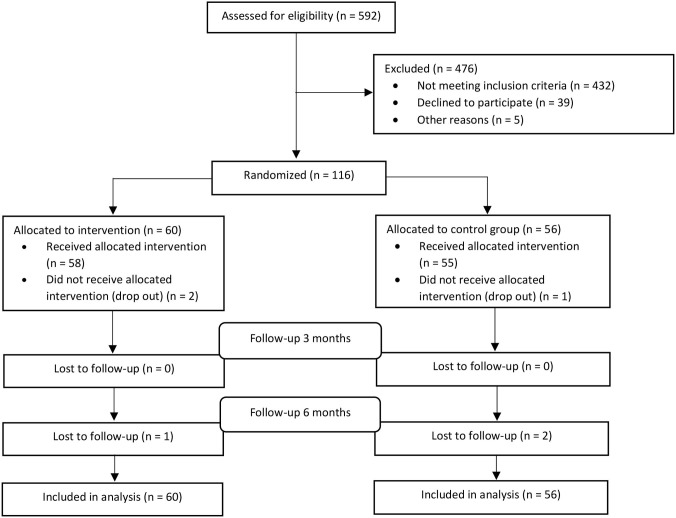
CONSORT flow chart.